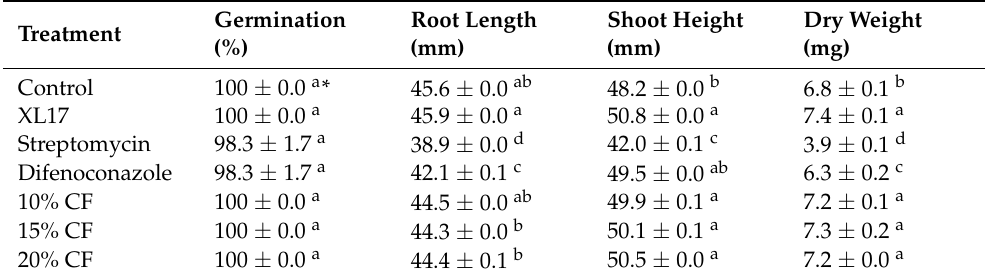
Table 1. Effects of strain XL17 and its culture filtrate (CF) on rice seed germination and growth. Treatment